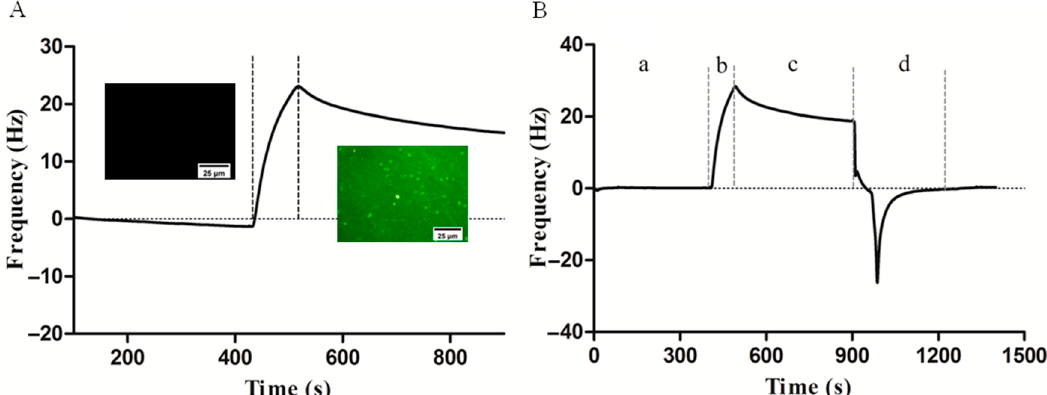
Figure 4. Binding of FITC-Con A to carbohydrate sensor ( A ) and QCM analysis of the binding of lectin with carbohydrate immobilized on the PFPA-modified sensor surface ( B ). Frequency shift was recorded during the association (84 s) and dissociation (300 s) phases of the interaction between lectin and carbohydrate, as well as the subsequent desorption of the remaining bound lectin by an injection of the 10 mM glycine pH 1.5. ( a ) baseline; ( b ) association; ( c ) dissociation; ( d ) regeneration.